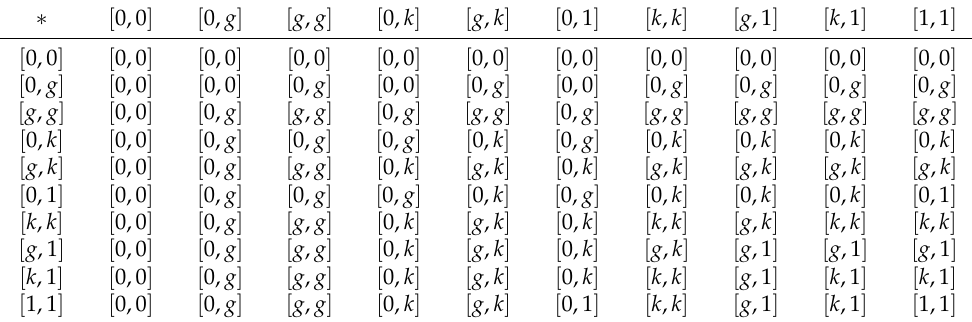
Table 4. The operator ∗ of algebra in Example 7.